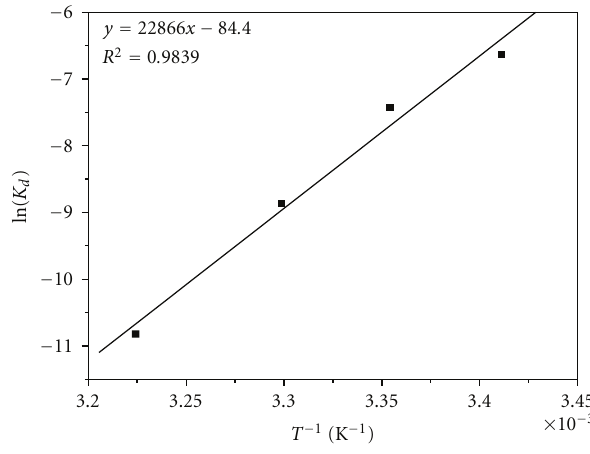
Figure 4: Thermodynamic parameters for the CLP-A-binding interaction to HSA are determined by the van’t Ho ff equation